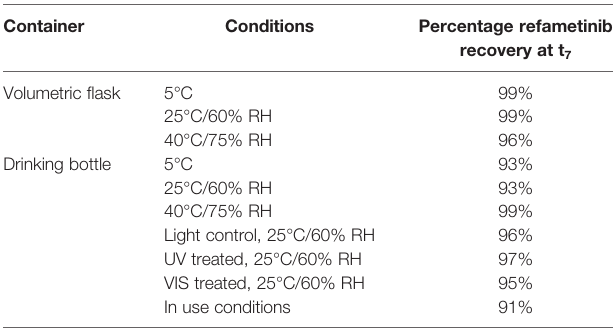
RH, relative humidity; UV, ultraviolet light; VIS, visible